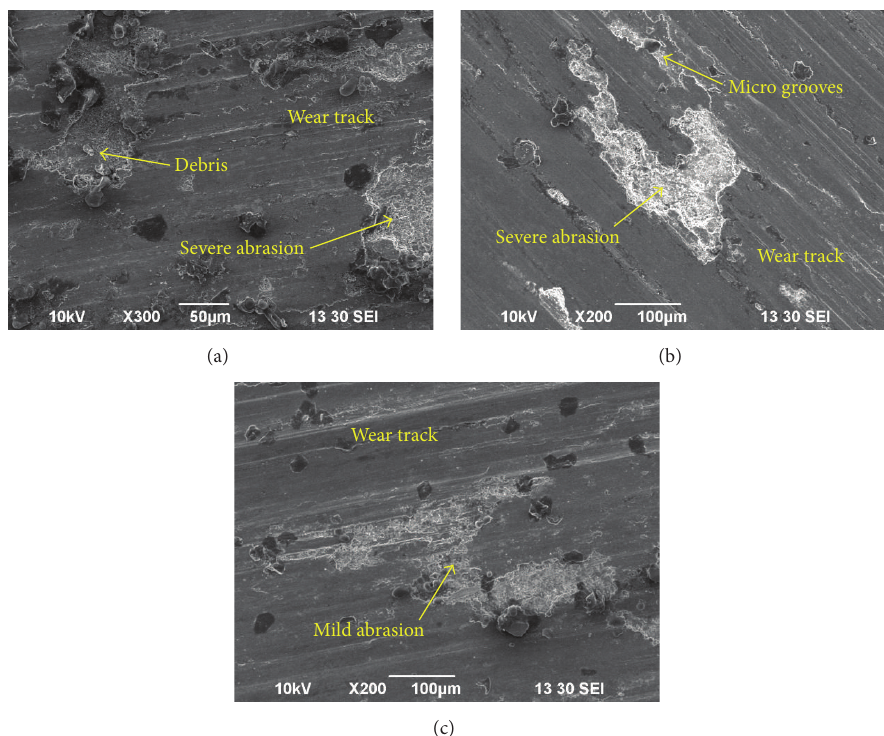
Figure 3: Worn surface: (a) A1 B2 C1 D1, (b) A1 B2 C2 D2, and (c) A1 B2 C3